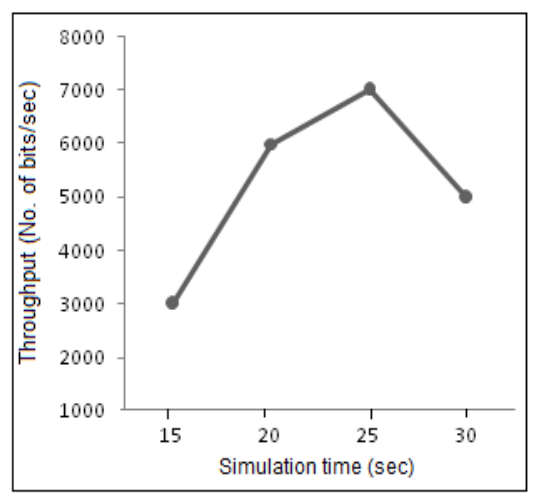
Figure 6. Throughput in bits/second vs simulation